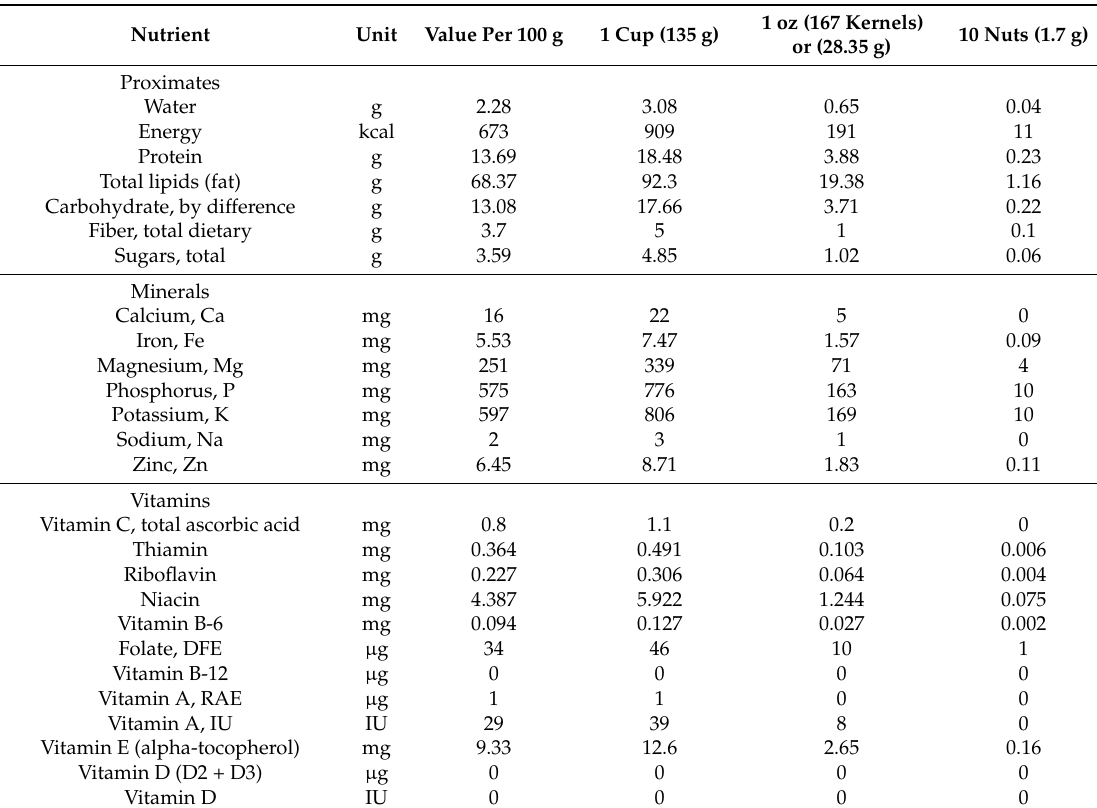
Table 2. Nutrient values and weights for edible portion of pine